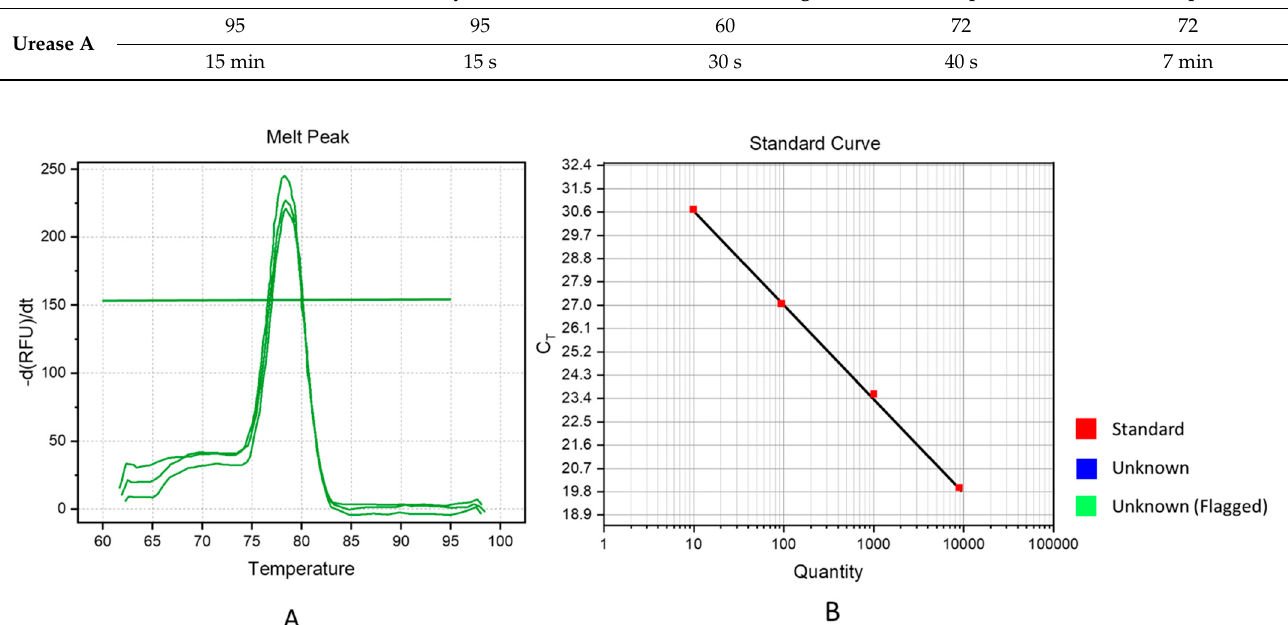
Figure 3. qPCR using the primer DNA gyrase: melting curve peaks ( A ) and standard curve ( B ); all peaks were at 65 for the detection of DNA gyrase B gene in the strains of H. pylori.